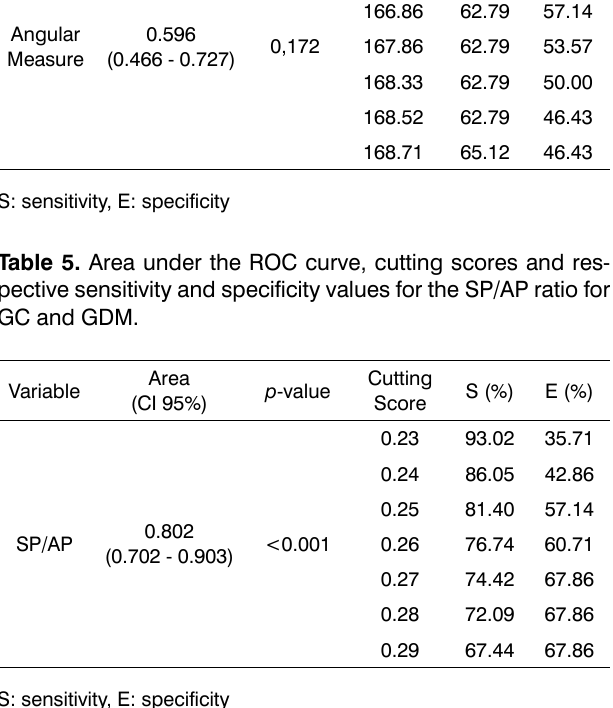
Table 6. Area under the ROC curve, cutting scores and res-